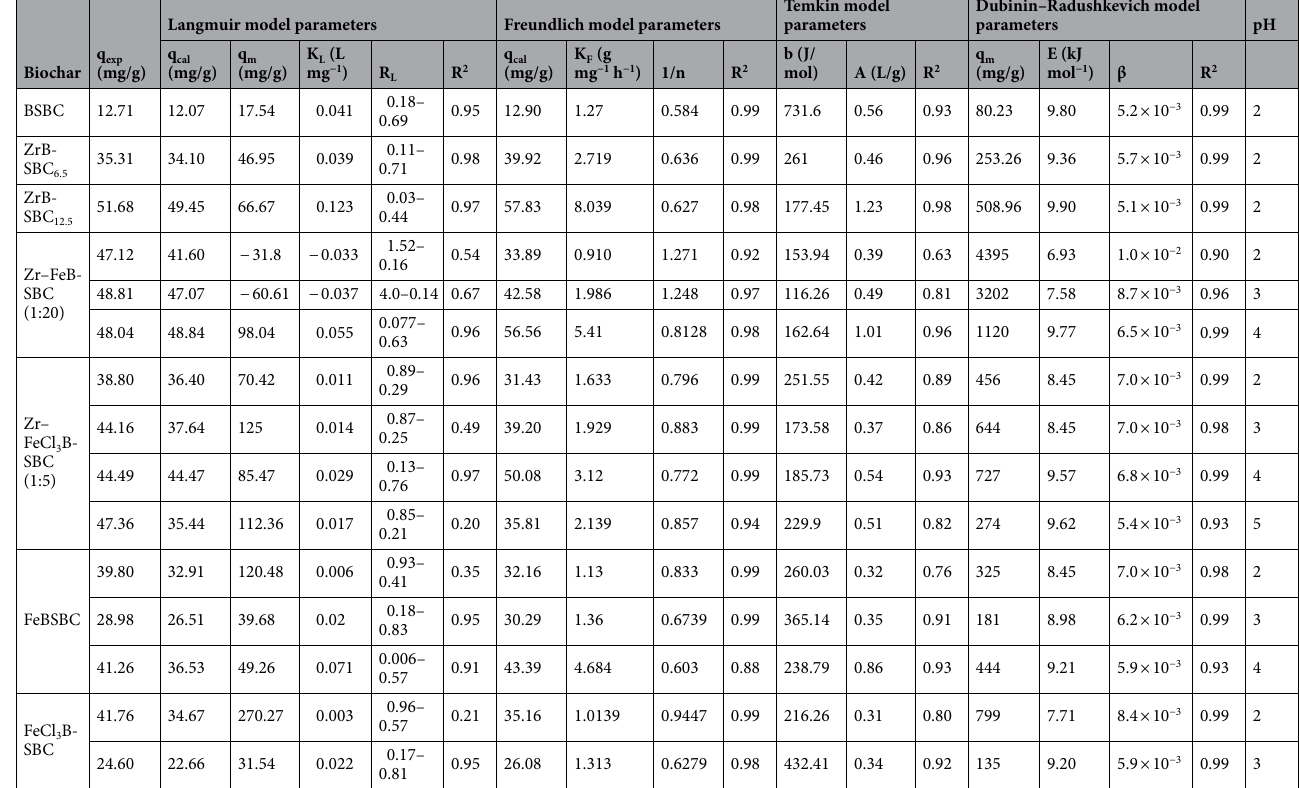
Table 2. Sorption isotherm models and best-fit parameters for Sb(V) sorption data.